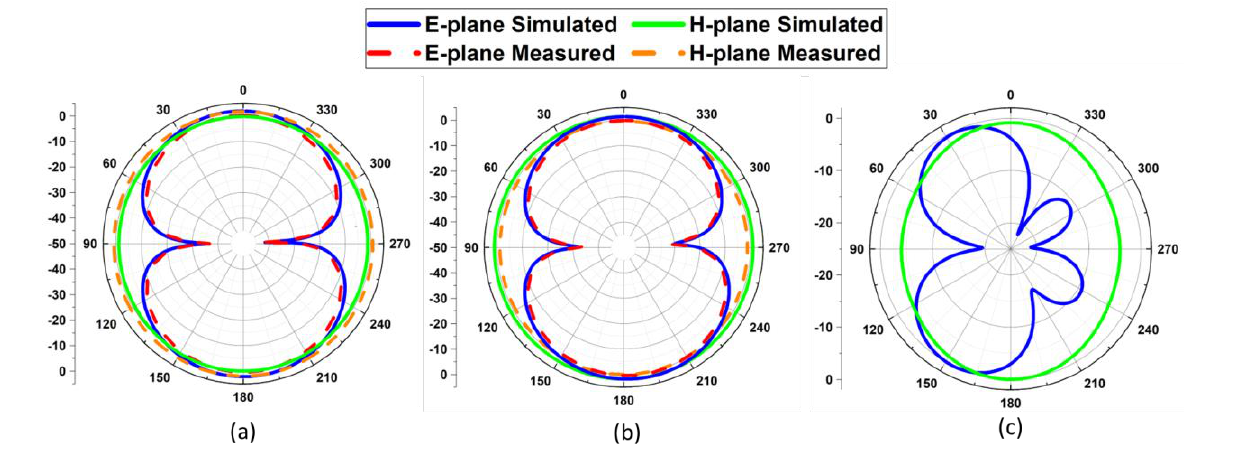
Figure 8. The 2D pattern of the proposed design; ( a ) at 28 GHz, ( b ) at 38 GHz, and ( c ) at 60 GHz.